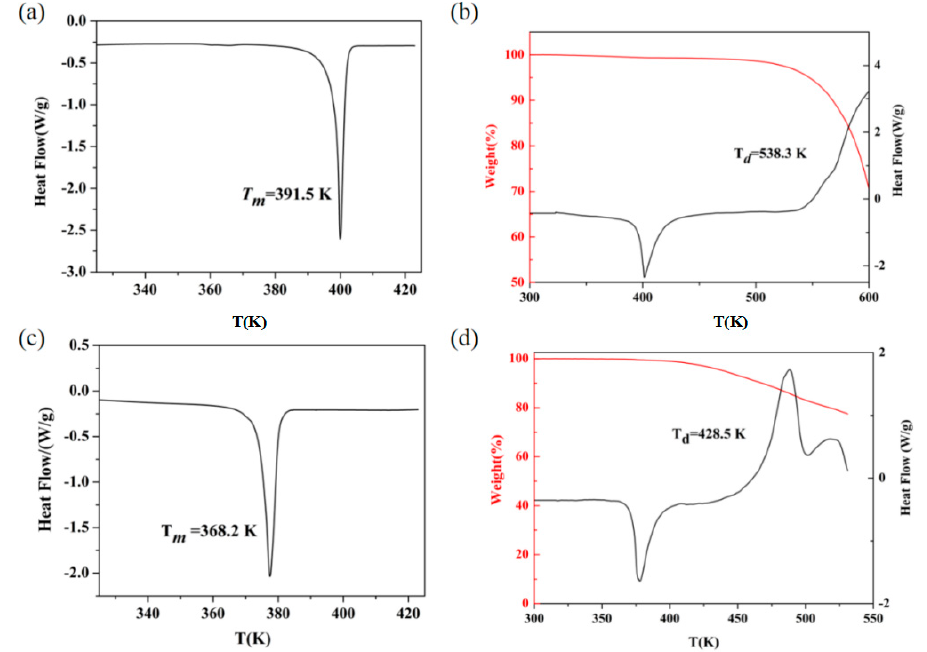
Figure 2. DSC and TGA plots of ( a , b ) 6cazpy crystals and ( c , d ) complex-I